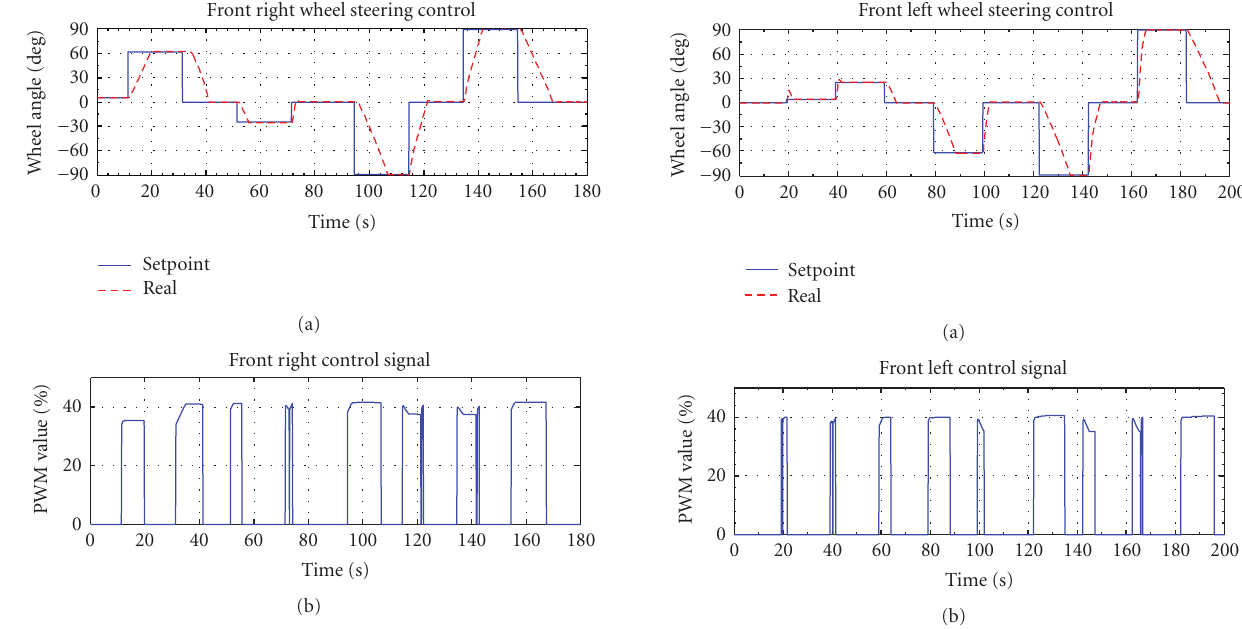
Figure 9: Front left wheel. (a) Wheel steering response comparing desired and real position. (b) Dynamic of PWM